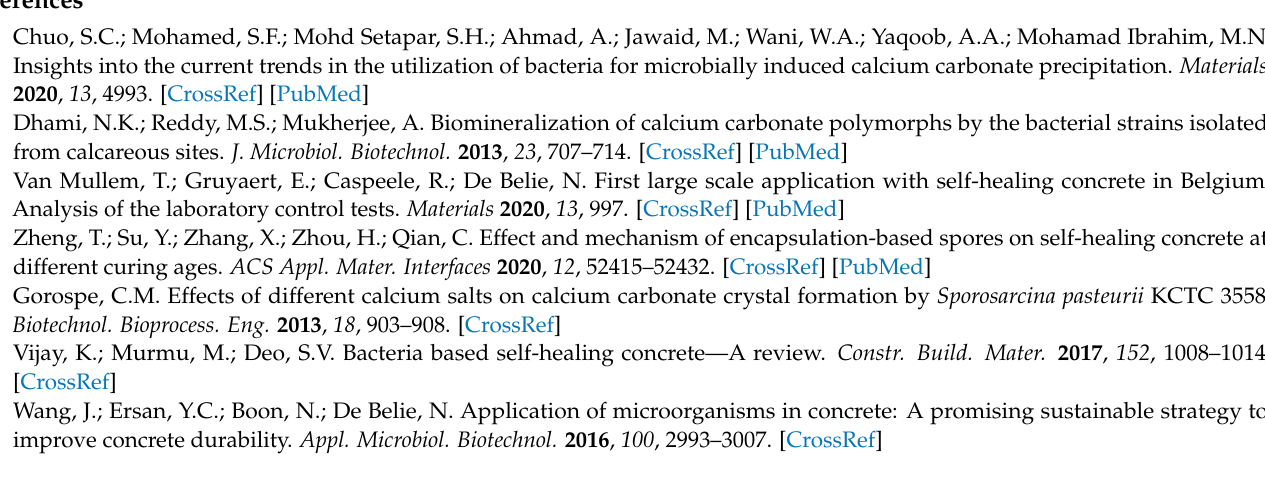
Table S2: SD value of urease activity of bacterial isolates grown on TSB supplemented with 2% urea at 150 rpm, 28 ◦ C for 48 h; Table S3: SD value of experimental viability of bacterial spores in the accelerated storage